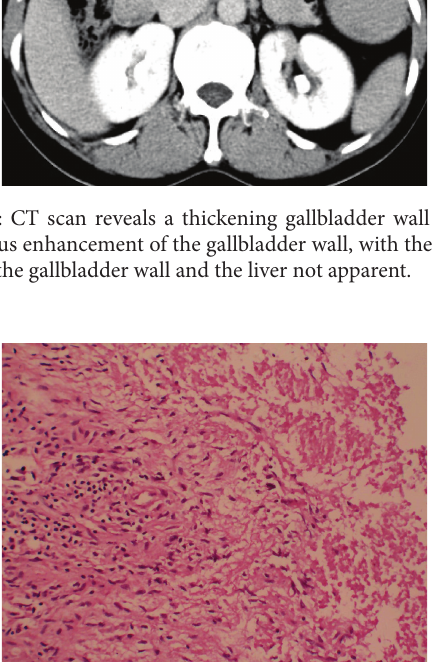
Figure 2: Microscopical view shows epithelioid granuloma along with typical Langhans giant cells (HE, original magnification ×